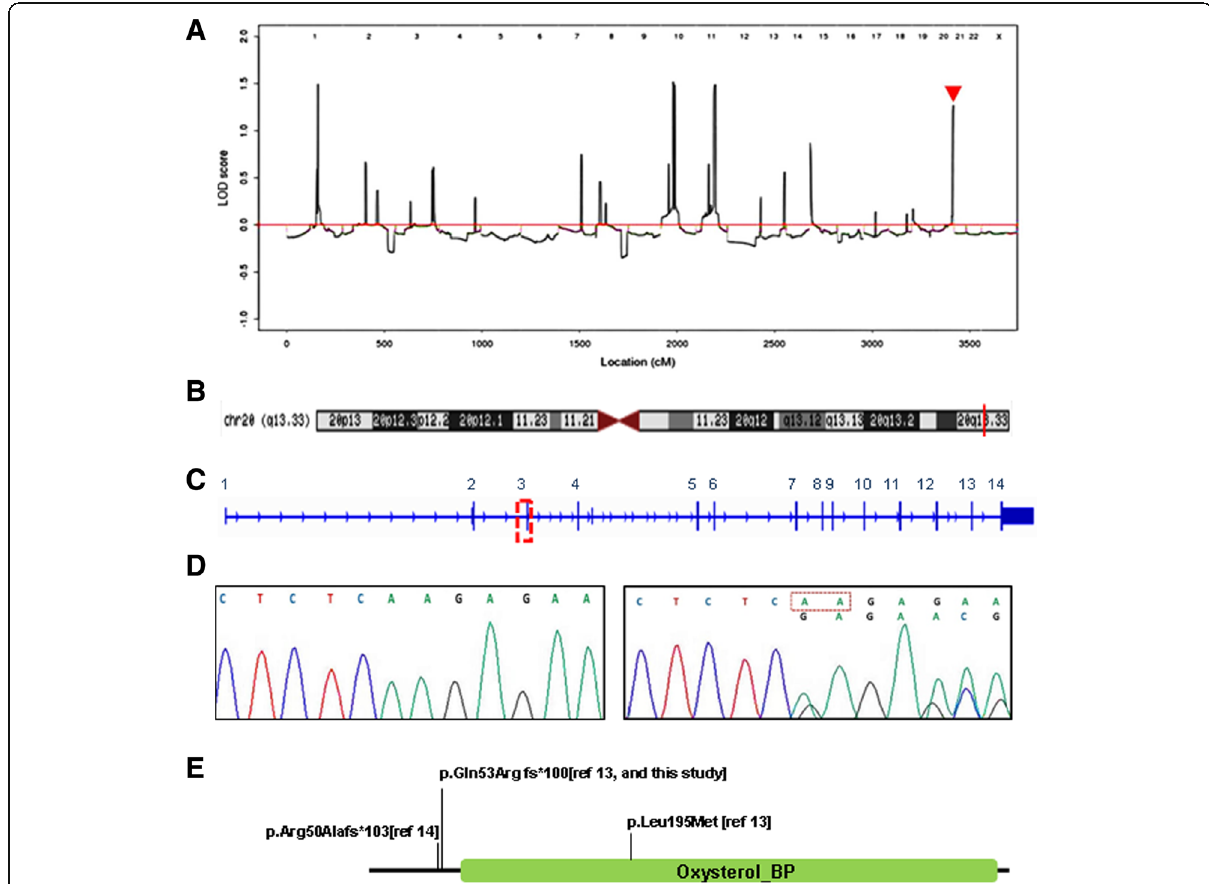
Fig. 3 Genetic analysis of deafness family. a Linkage analysis detects four loci with LOD score around 1.5, red arrow points to the locus of OSBPL2 . b OSBPL2 is located on chromosome 20q13.33 (red bar). c The OSBPL2 deletion is detected in exon 3 (red box). d Sequencing chromatograms of OSBPL2 shows a heterozygous frameshift deletion c.158_159delAA (deleted nucleotides are boxed) in DNA from affected patients (right) as compared to that from control (left). e The c.158_159delAA (p.Gln53Arg fs*100) mutation of OSBPL2 occurs before the oxysterol binding domain. Other published mutations on OSBPL2 were also